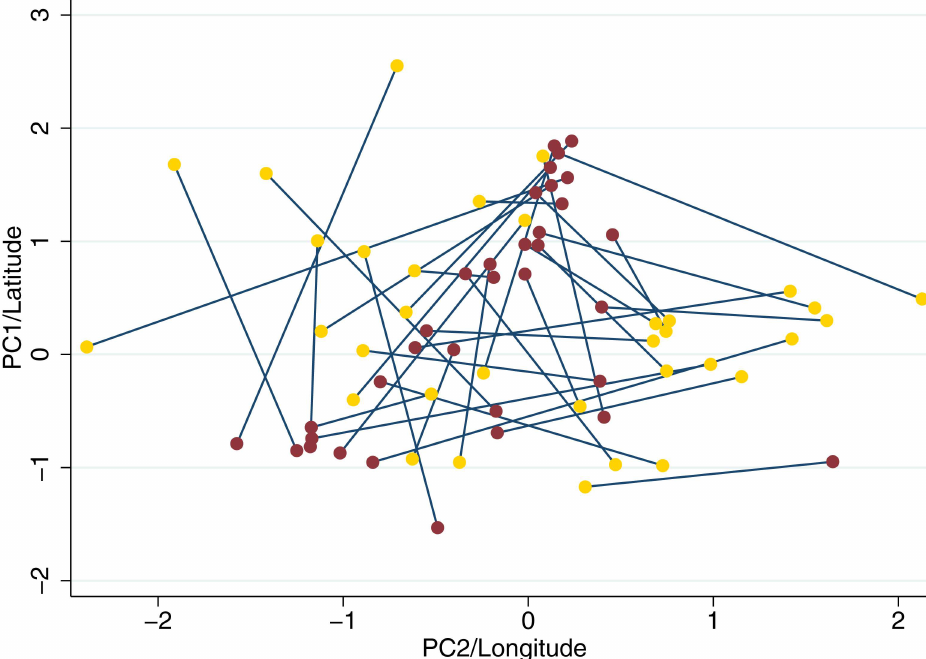
Fig 3. Plot of standardised values for the ancestry informative principle components 1 & 2 (red) and latitude & longitude (gold) for HIV sequences, with values for each sequence linked by a line. No correlationbetween geographicposition and genetic position was